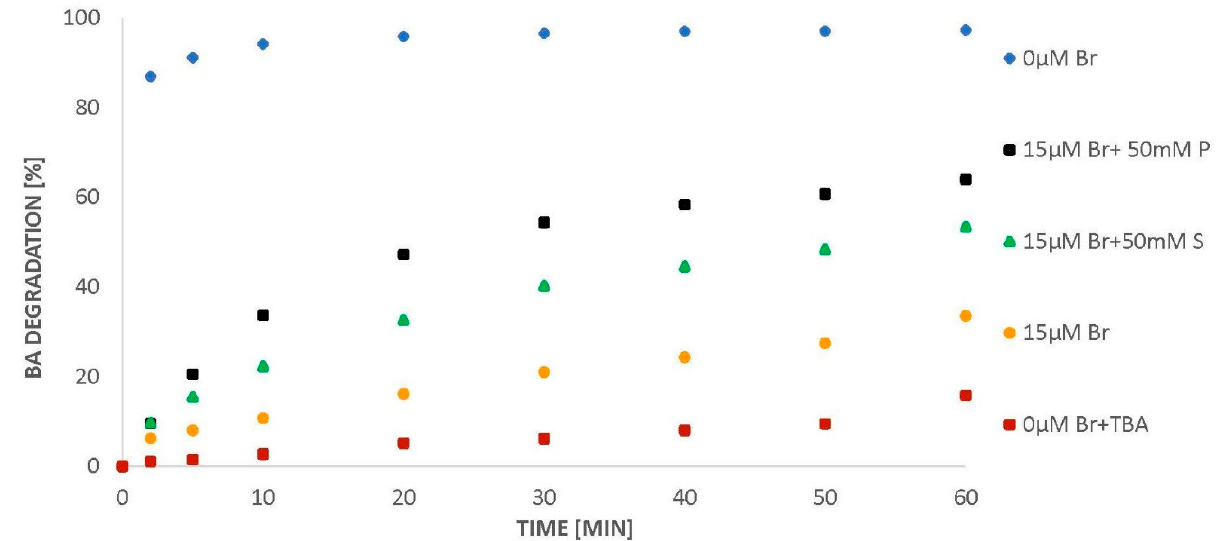
Figure 8. BA degradation (24 µM) in the presence of bromides (0 and 15 µM) and 50 mM sulphates (S) or phosphates (P), pH = 2.5.